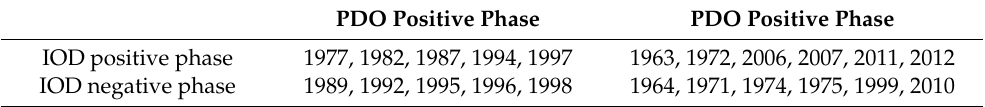
Table 1. Phase combinations of PDO and